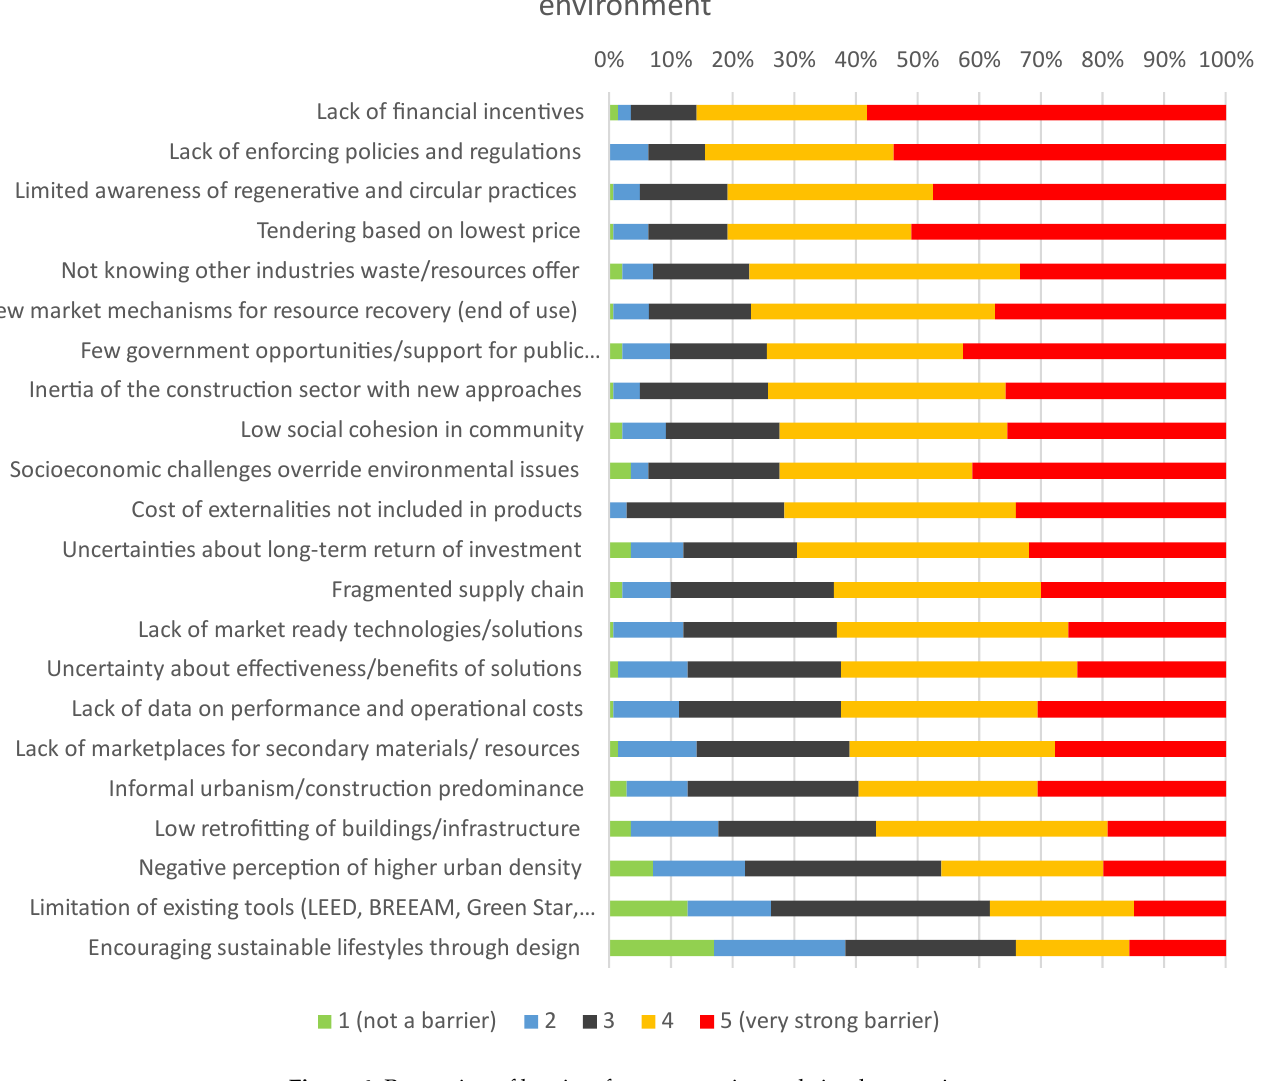
Figure 6. Perception of barriers for regenerative and circular practices.